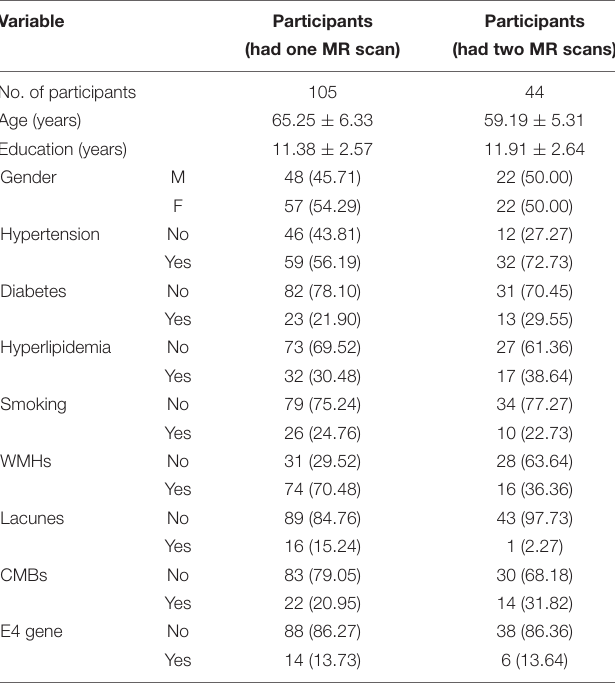
TABLE 1 | Description of demographic characteristics and risk factors [mean ± SD or n